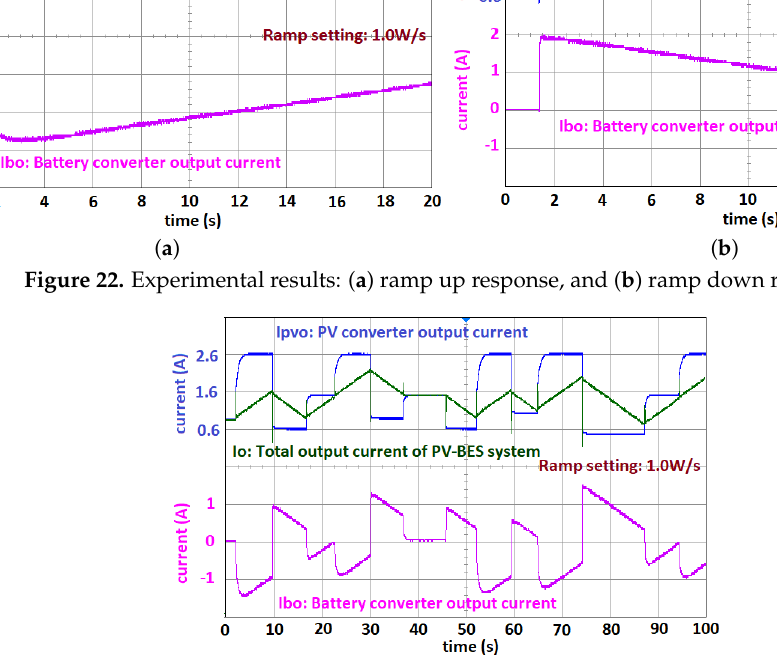
Figure 23. Experimental result: ramp up/down response for random PV power changes.